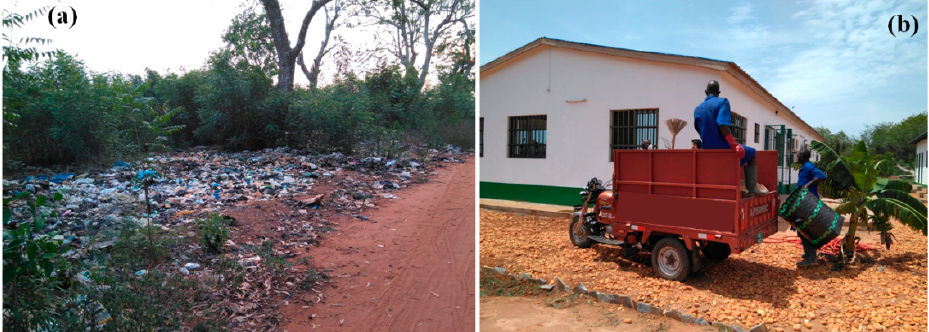
Figure 2. ( a ) Uncontrolled dump and ( b ) waste collection team on the campus of the University of